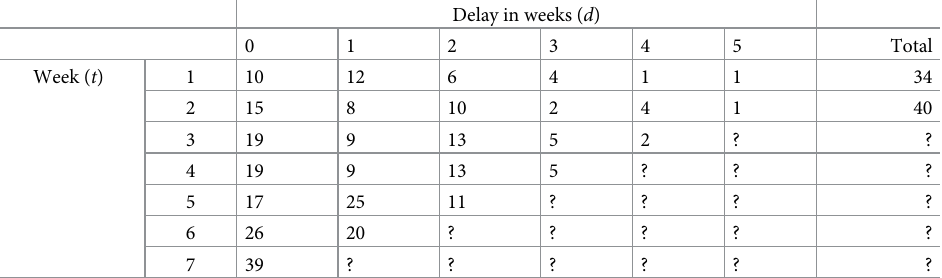
Table 2. Stylised example of chikungunya case count data availability for a given week. This matrix provides a styl- ised example of the chikungunya case count data available when nowcasting cases for a given week. In this example, we hold data from week 1 onwards and are currently in week 7. For ease of illustration, we assume here that the maximum delay in entering a case into the surveillance system is five weeks. Each row represents a previous week ( t ) of entered cases, and the column represents the entry delay ( d ) in weeks. For example, we can see that there were initially 15 cases entered into the system in week 2, 8 further cases after a delay of 1 week, 10 cases after a delay of 2 weeks, and so on. Case data is incomplete, not only for week 7 but also weeks 3 through 6. The incompleteness is usually worse the closer the week to the current period, so there is a running “triangle” of unknown case counts and associated delays to be esti- mated for previous weeks. Estimating each cell in the last row of this triangle yields a nowcast of the total case count for week 7. The method introduced by Bastos et al. [21] provides an approach for generating these estimates. Delay in weeks ( d ) 0